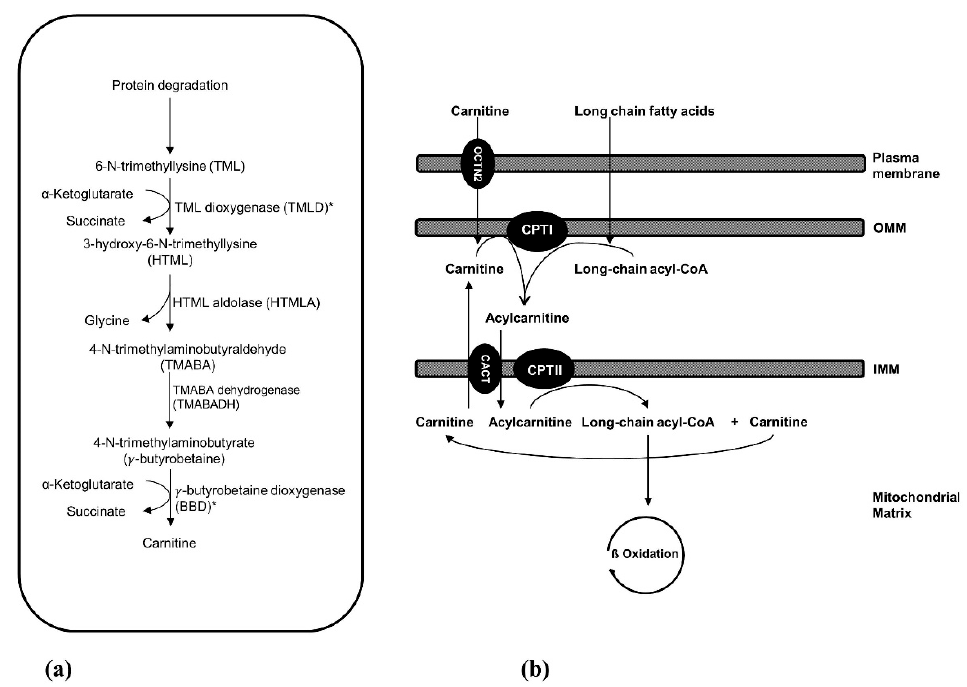
Figure 1. ( a ) Carnitine biosynthetic pathway. Only trimethyllysine dioxygenase (TMLD) and γ -butyrobetaine dioxygenase (BBD) deficiencies have been reported; both are denoted with asterisks. ( b ) Carnitine transport and mitochondrial carnitine–acylcarnitine cycle. IMM: inner mitochondrial membrane; OMM: outer mitochondrial membrane; CPT I: carnitine palmitoyltransferase I; CACT: